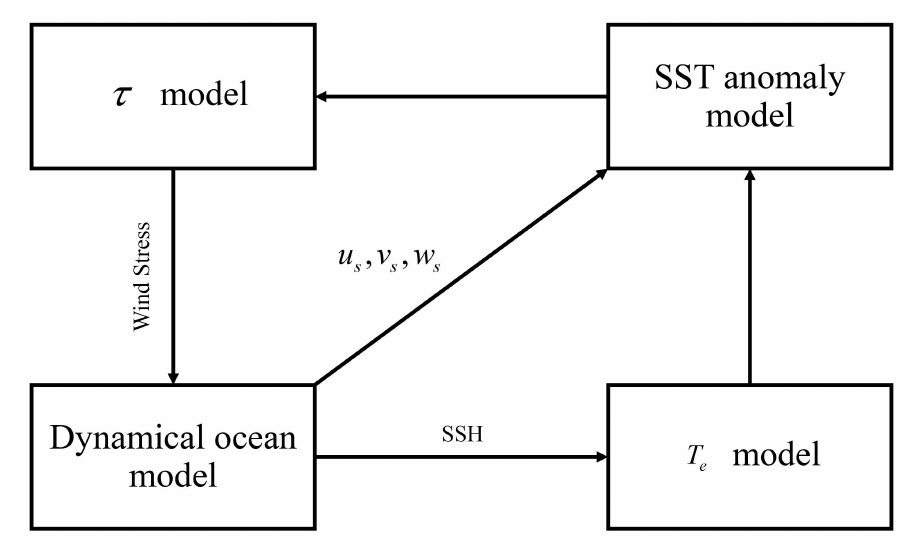
Figure 1. General simple structure of the EICM